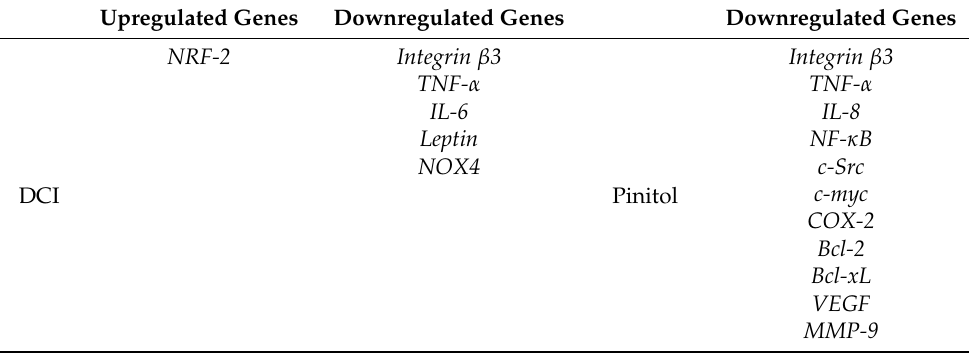
Table 1. The table summarizes the in vitro evidence existing on the molecular regulation by DCI and Pinitol of genes relevant in cancer progression. c-Src: Proto-oncogene tyrosine protein kinase Src; COX2: cyclooxygenase-2; DCI: D-chiro-inositol; MMP-9: matrix metalloprotease-9; Nf- κ B: nuclear factor kappa-light-chain-enhancer of activated B cells; NOX4: NADPH oxidase 4; NRF2: